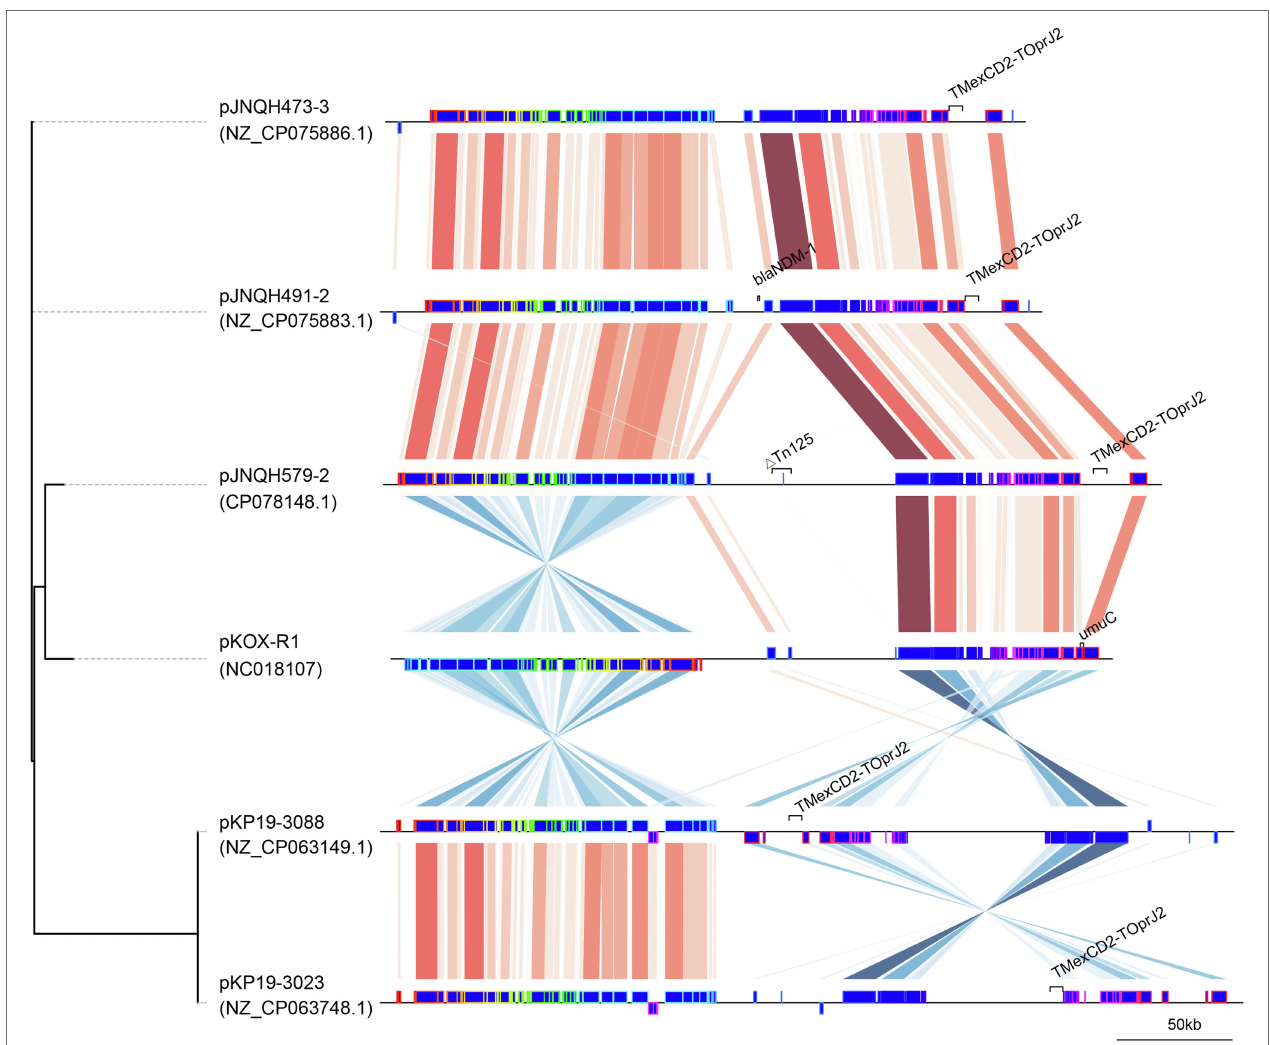
FIGURE 3 | Comparison of linear plasmid maps of four TmexCD2-ToprJ2 -bearing plasmids and the related plasmid pKOX-R1. The genomes were compared with Mauve and the elements were designated as Mauve blocks. Red shaded regions between plasmids indicates shared regions of homology, while blue shading indicates inversely displayed regions of homology. The tree was created using